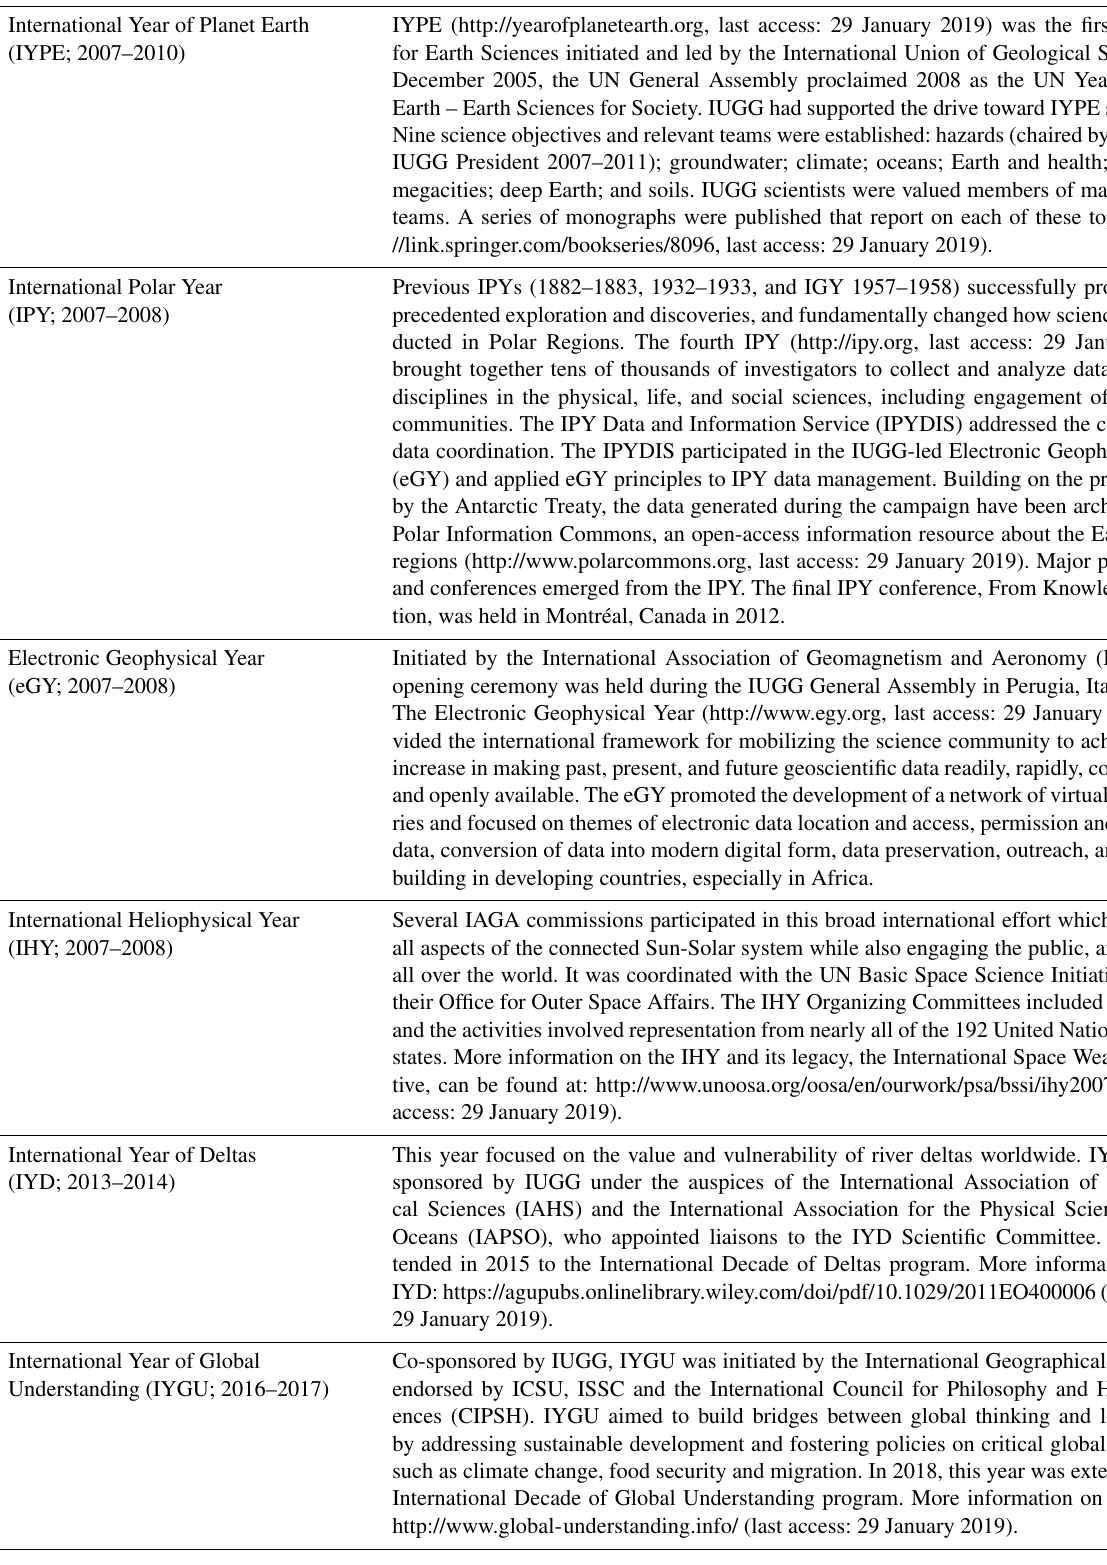
Table 1. International Years initiated or supported by IUGG